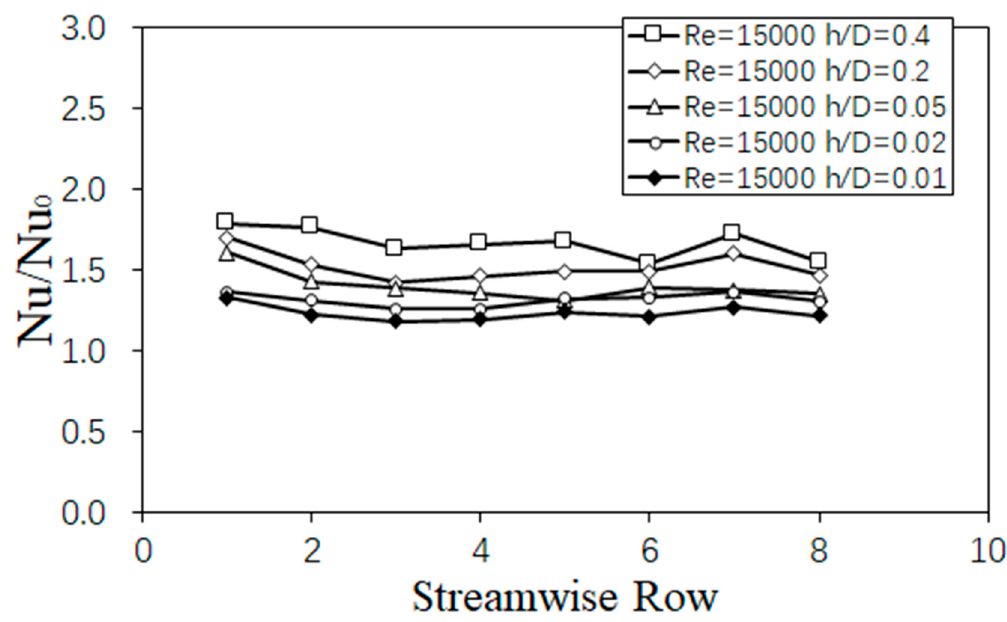
Figure 19. Spatially averaged Nusselt number ratios as dependent on streamwise row location, for micro cooling units height, for Re (cid:2920) = 15,000.